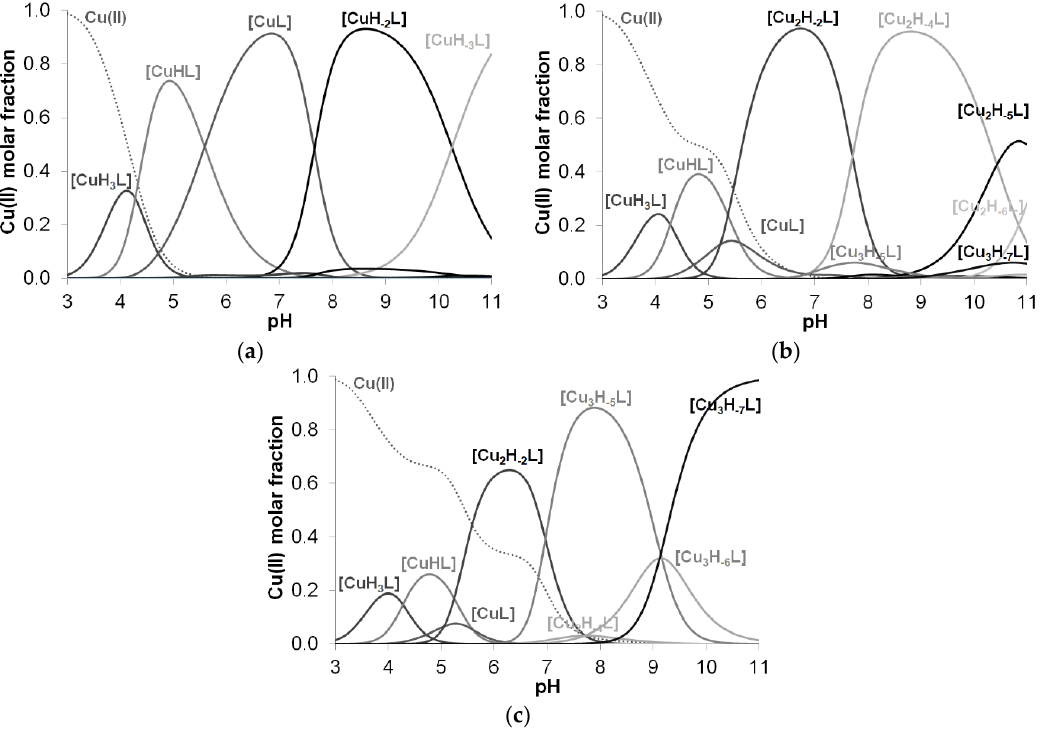
Figure A4. Distribution curves of complexes formed in the Cu(II)-Ac-HDHAHDH-NH2 solution at 1:1 ratio, c L = 2 mM ( a ); at 2:1 ratio, c L = 1 mM ( b ) and at 3:1 ratio c L = 1 mM ( c ).